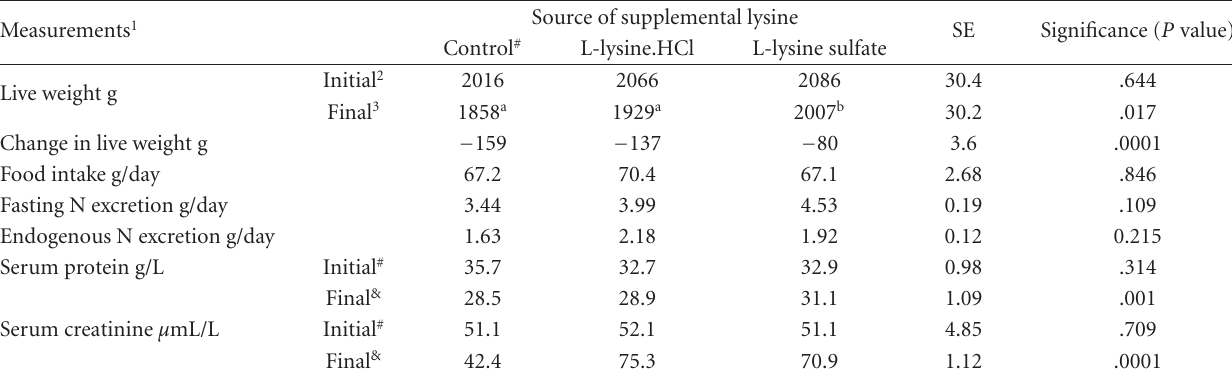
Table 6: Estimation of fasting and endogenous nitrogen loss in the experimental broiler